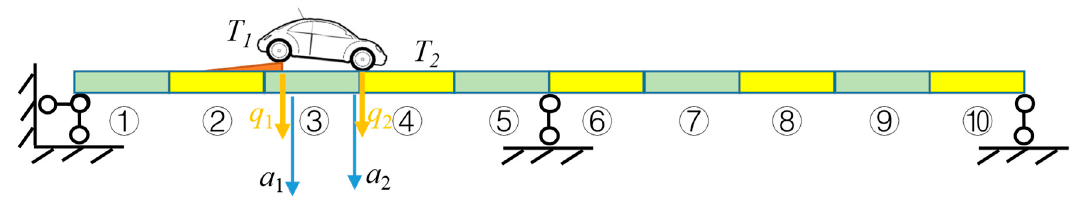
Figure 19. A two-span continuous bridge with 4-DOF vehicle model ( T 1 Figure 19. A two ‐ span continuous bridge with 4 ‐ DOF vehicle model ( T 1 bump).